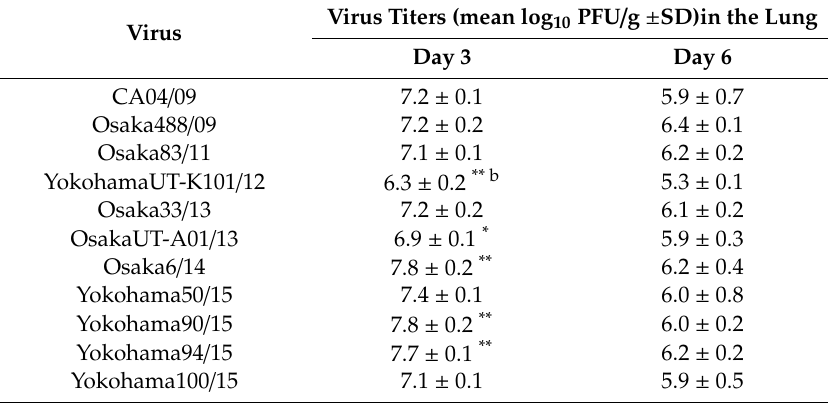
Table 3. Replicative ability of the Japanese A(H1N1)pdm09 and CA04 / 09 viruses a